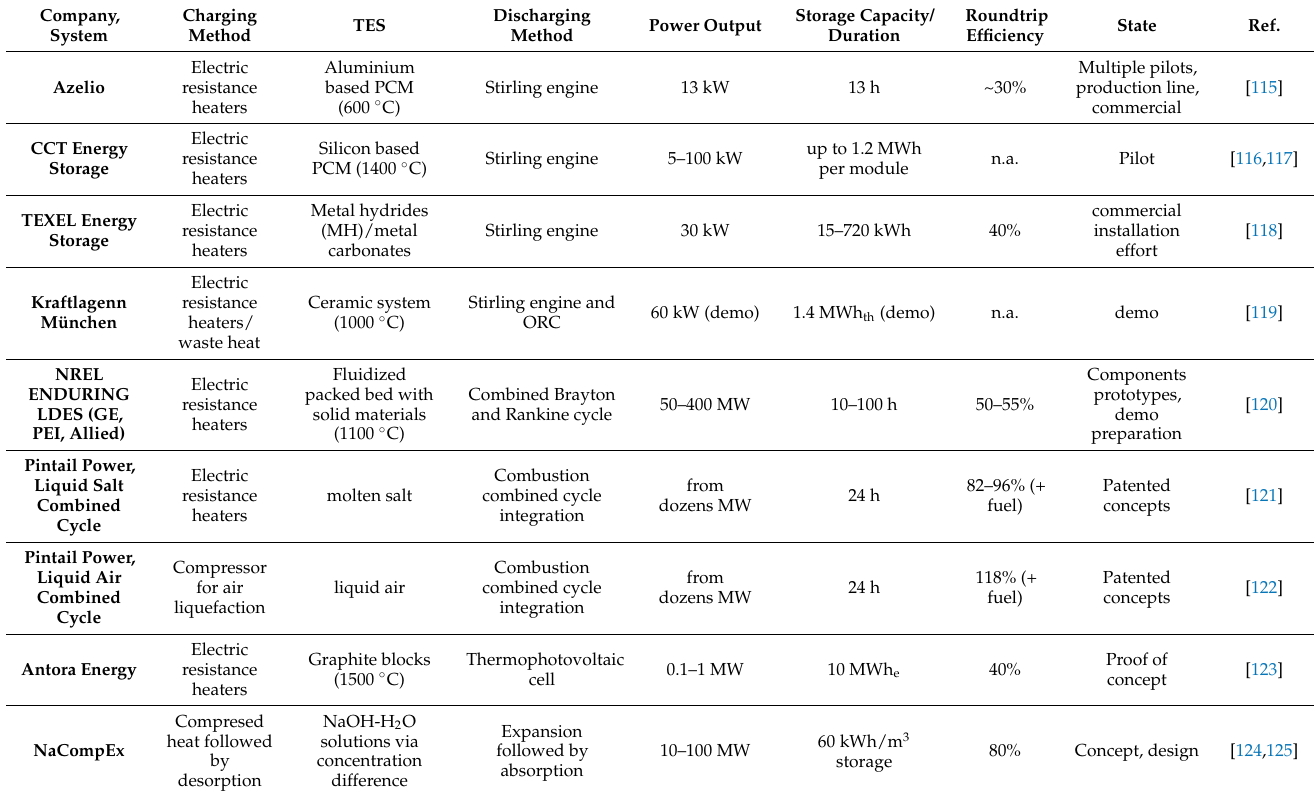
Table 3. List of commercial development projects in CB in the other and hybrid discharging cycle